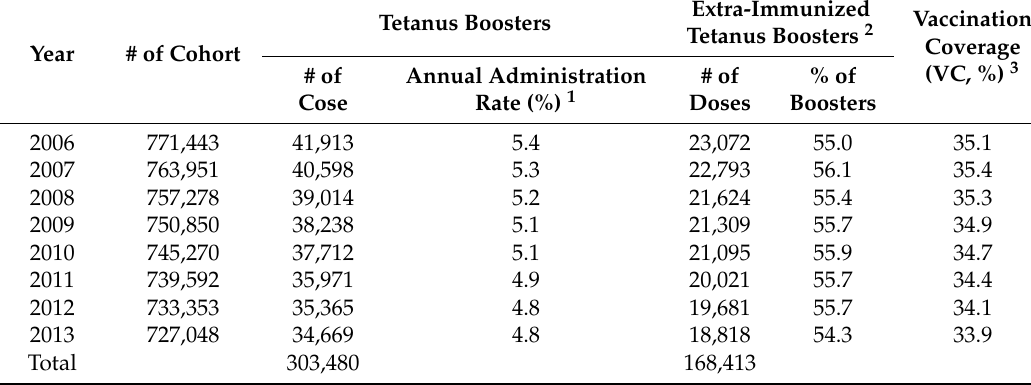
Table 1. Annual trends of tetanus administration rates, proportion of extra-immunization boosters and vaccination coverage among adults aged between 20 and 79 years in Taiwan’s representative cohort.